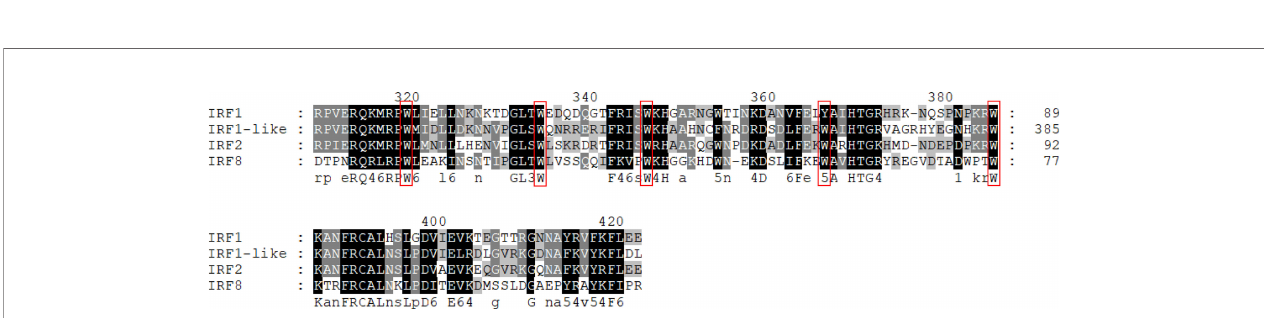
FIGURE 3 | Alignment of DBD domains of the four Cf IRF proteins. Alignment was performed using ClustalW2. Identical residues are indicated in black, and similar residues are in light gray. Dashes indicate gaps. Five conserved tryptophan (W) residues are marked with red